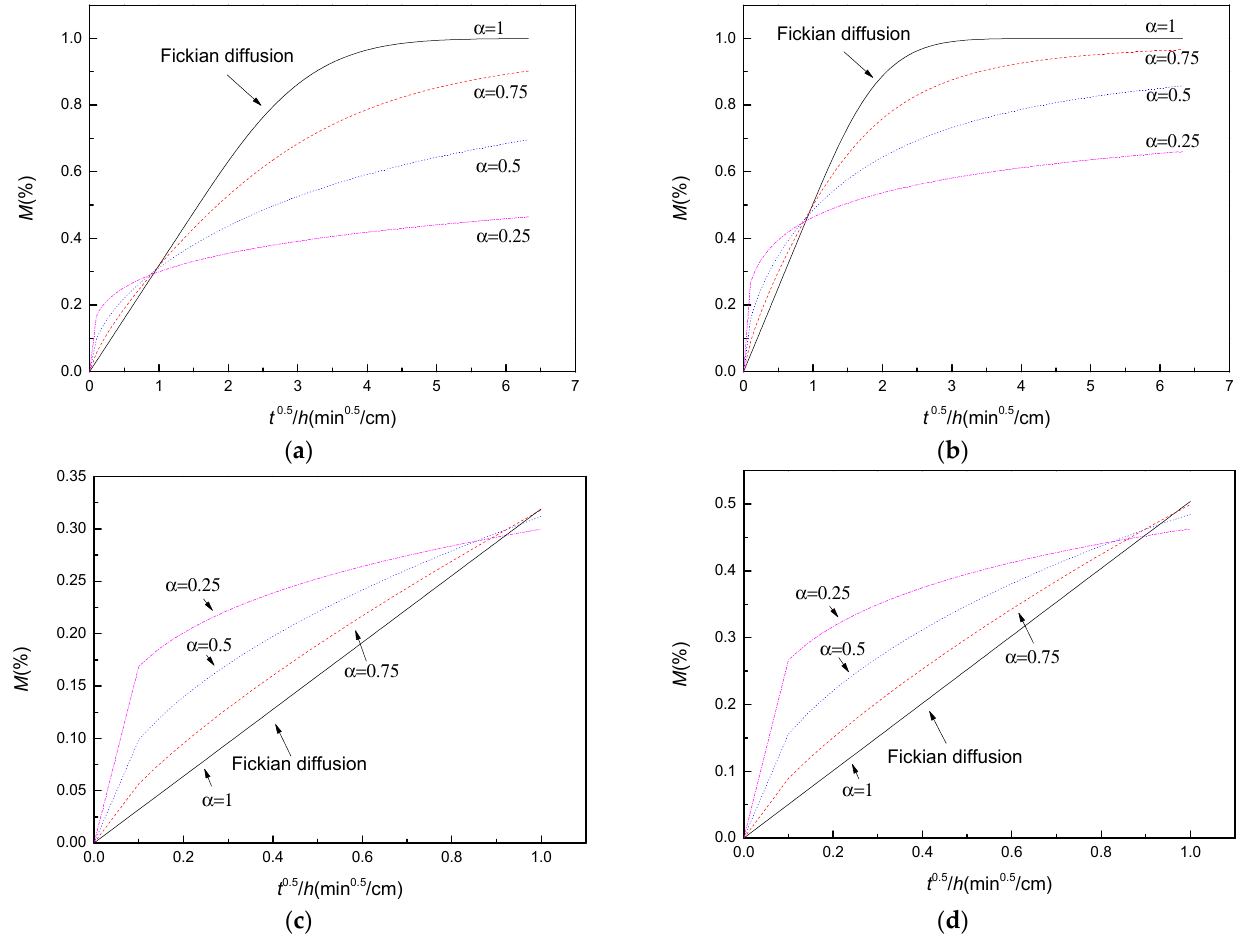
Figure 3. The moisture uptake calculated by time fractional moisture diffusion Equation (9) for four cases. ( a ) D = 0.02 cm 2 /min, 0 ≤ t ≤ 40 min; ( b ) D = 0.05 cm 2 /min, 0 ≤ t ≤ 40 min; ( c ) D = 0.02 cm 2 /min, 0 ≤ t ≤ 1 min; and ( d ) D = 0.05 cm 2 /min, 0 ≤ t ≤ 1 min. The solid lines are Fickian diffusion (black, α = 1). The dash (red), dot (blue) and dash dot(magenta) lines are α = 0.75, 0.5 and 0.25,